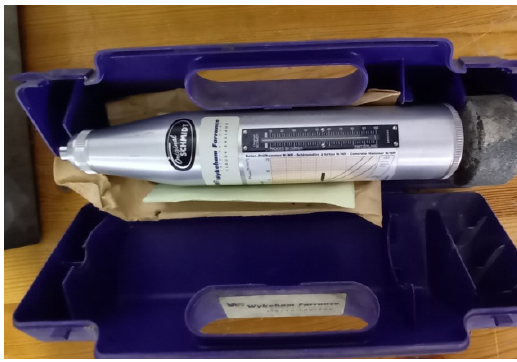
Figure 4. Schmidt Hammer apparatus.